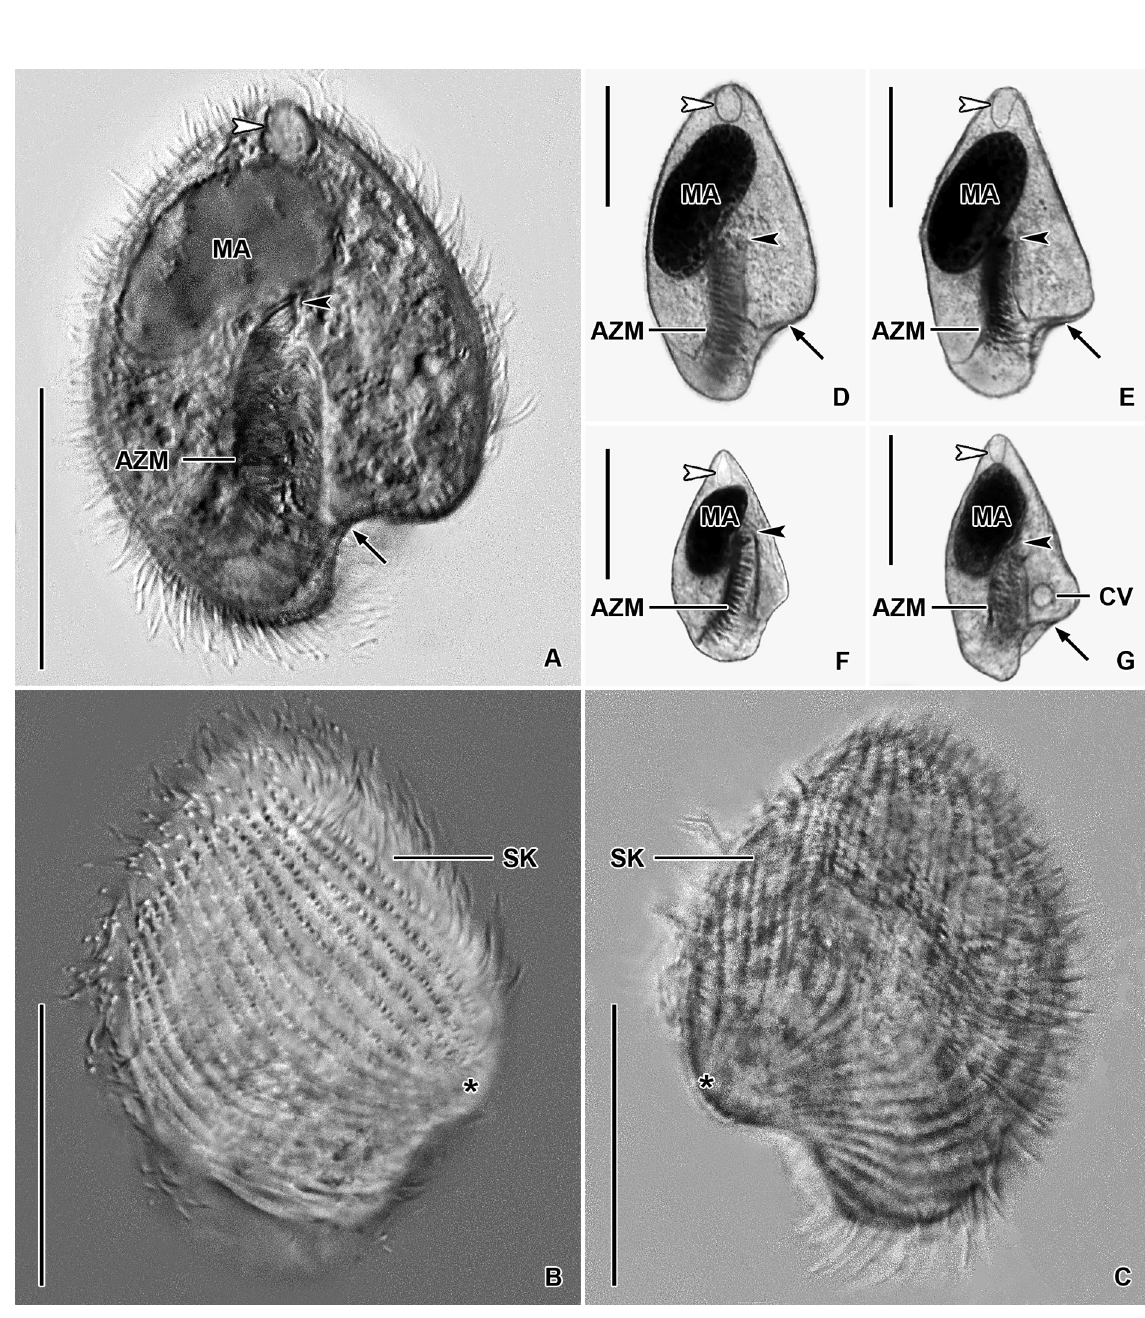
Fig. 14. Paraclevelandia brevis Kidder, 1937. Thai I specimens (a–C, F–G) isolated from Panesthia angustipennis angustipennis (Illiger, 1801) and Vietnamese specimens (D–E) isolated from Panesthia angustipennis cognata Bey-Bienko, 1969 from life (a–C) and after protargol impregnation (D–G). A . Ventral overview, showing the general body organization. Arrows mark the proximal end of the peristomial opening, black arrowheads denote the proximal end of the adoral zone of membranelles, white arrowheads denote the karyophore attached to the anterior body pole. B–C . Ciliary pattern of ventral and dorsal sides. Asterisks mark the position of the ciliary whorl (posterior suture). D–G . Ventral views of specimens with well-preserved body shape. Scale bars = 20